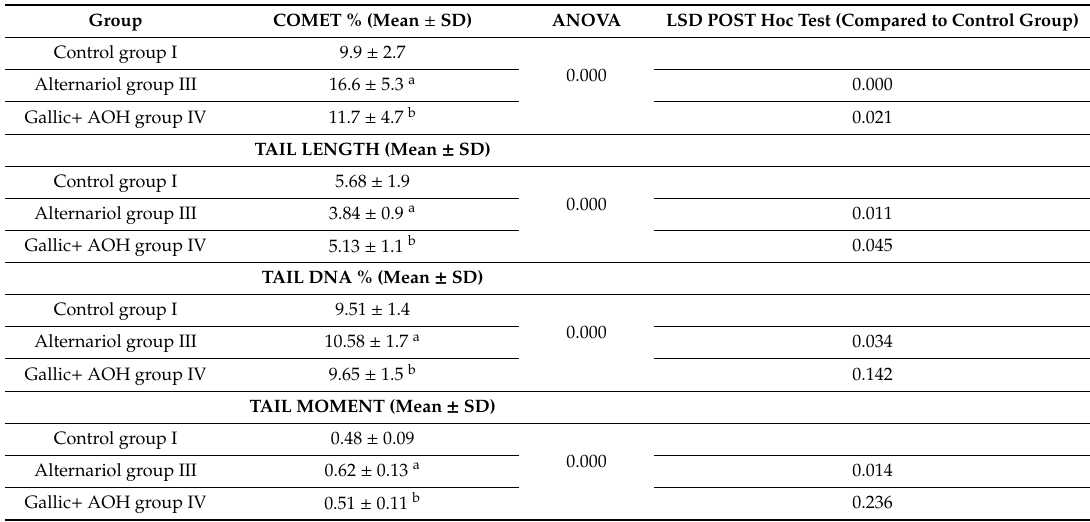
Table 2. Statistical comparison of Comet assay results in di ff erent groups.